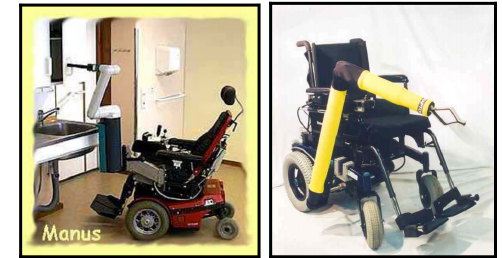
Figure 1. Manusand